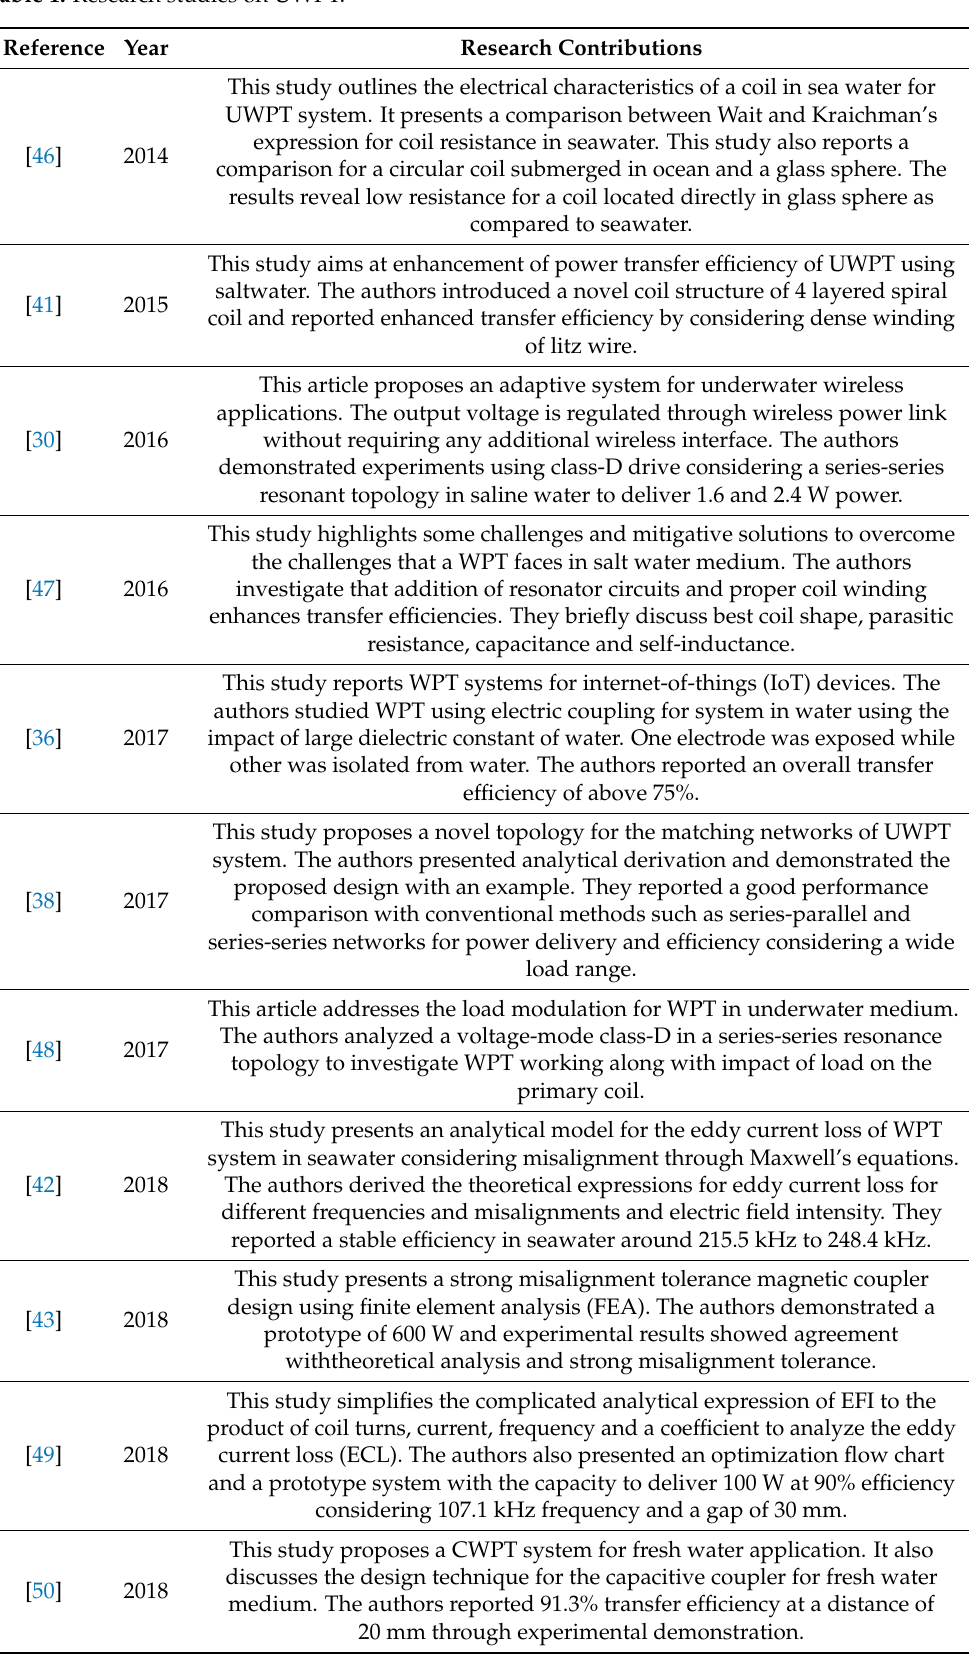
Table 1. Research studies on